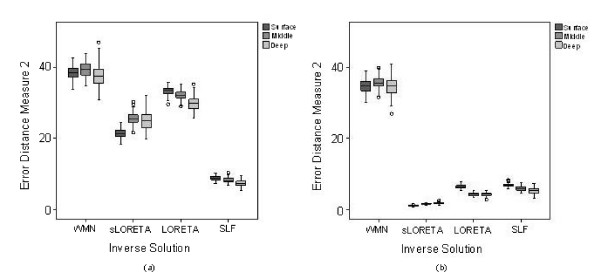
Box-whisker diagrams. These show the median (horizontal line within
                        each box), the interquartile range (between the bottom and top of each box)
                        and the range of scores (shown by the whiskers). Circles represent outliers.
                        Plots (a) and (b) show the results for each of the four inverse solutions
                        (horizontal axis) for error measure ED2 with a SNR of 5 dB. (a) shows the
                        results without regularization and (b) shows the results with
                        regularization.